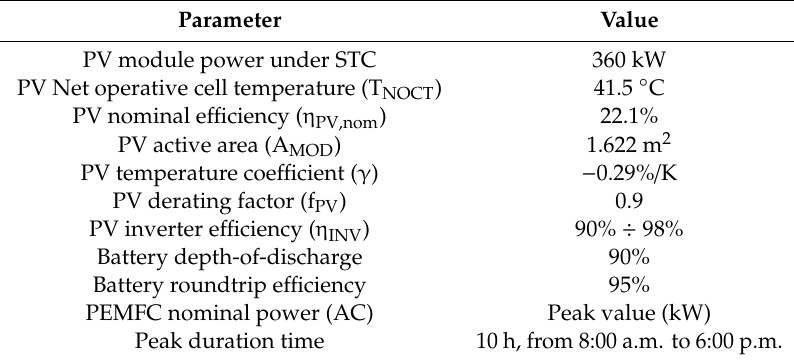
Table 1. Main characteristic of the hydrogen-based microgrid